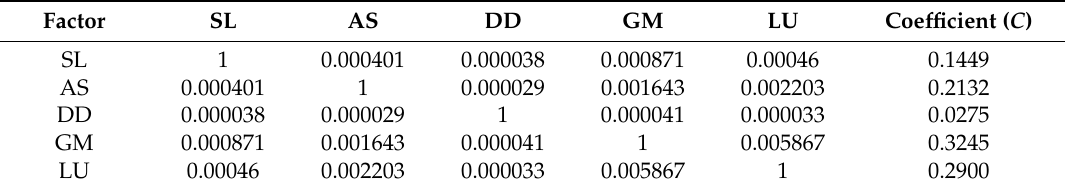
Table 6. The matrix of landslide factors’